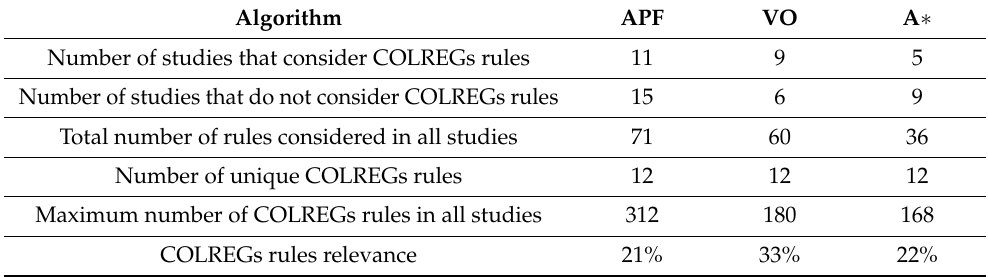
Table 11. COLREGs part B relevance of different local path-planning algorithms in maritime au- tonomous surface